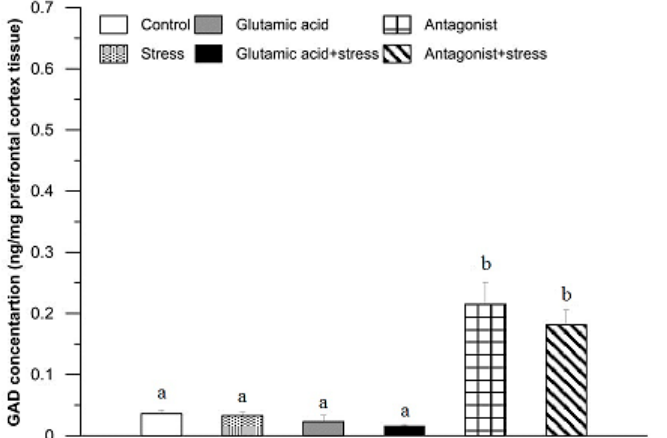
Figure 5. The effect of glutamic acid, stress, and glutamic acid receptor antagonist and their combinations with stress on the concentration of glutamic acid decarboxylase in the rabbit prefrontal cortex. For further explanations, see Figure 1.